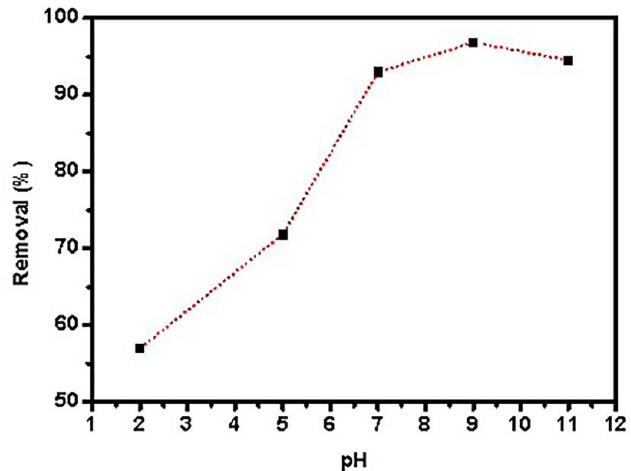
Figure 7. Effects of pH PTZS adsorption by GO-date Seeds (C 0 :11 mg/ L, T: 298 K, Adsorbent dosage: 0.05 g /L, Contact time: 30 min).